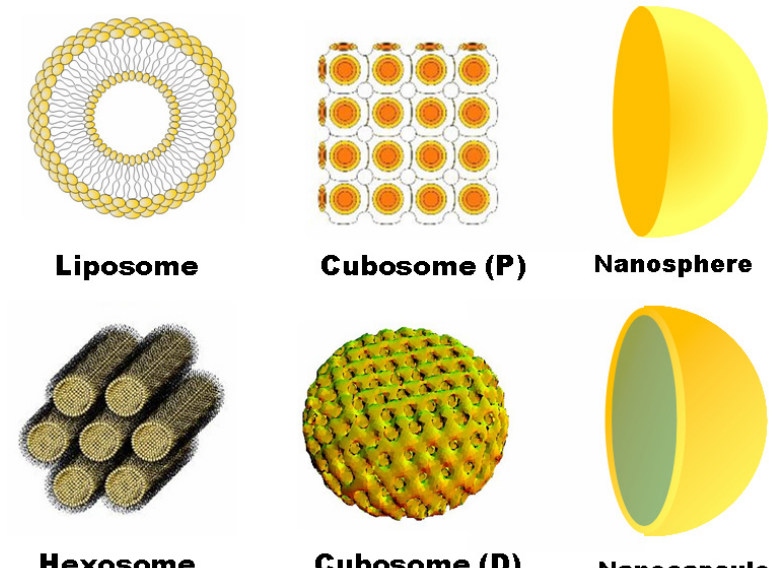
Figure 5. Lipid nanoparticulate carriers produced by soft nanotechnology. The channels allowing for protein nanoencapsulation are organized on an inner hexagonal lattice in the hexosome lipid particles, whereas the cubosome lipid particles can have different inner channel symmetries, such as primitive (P) cubic (cubosome of P-type) and diamond (D) cubic lattices (cubosome of